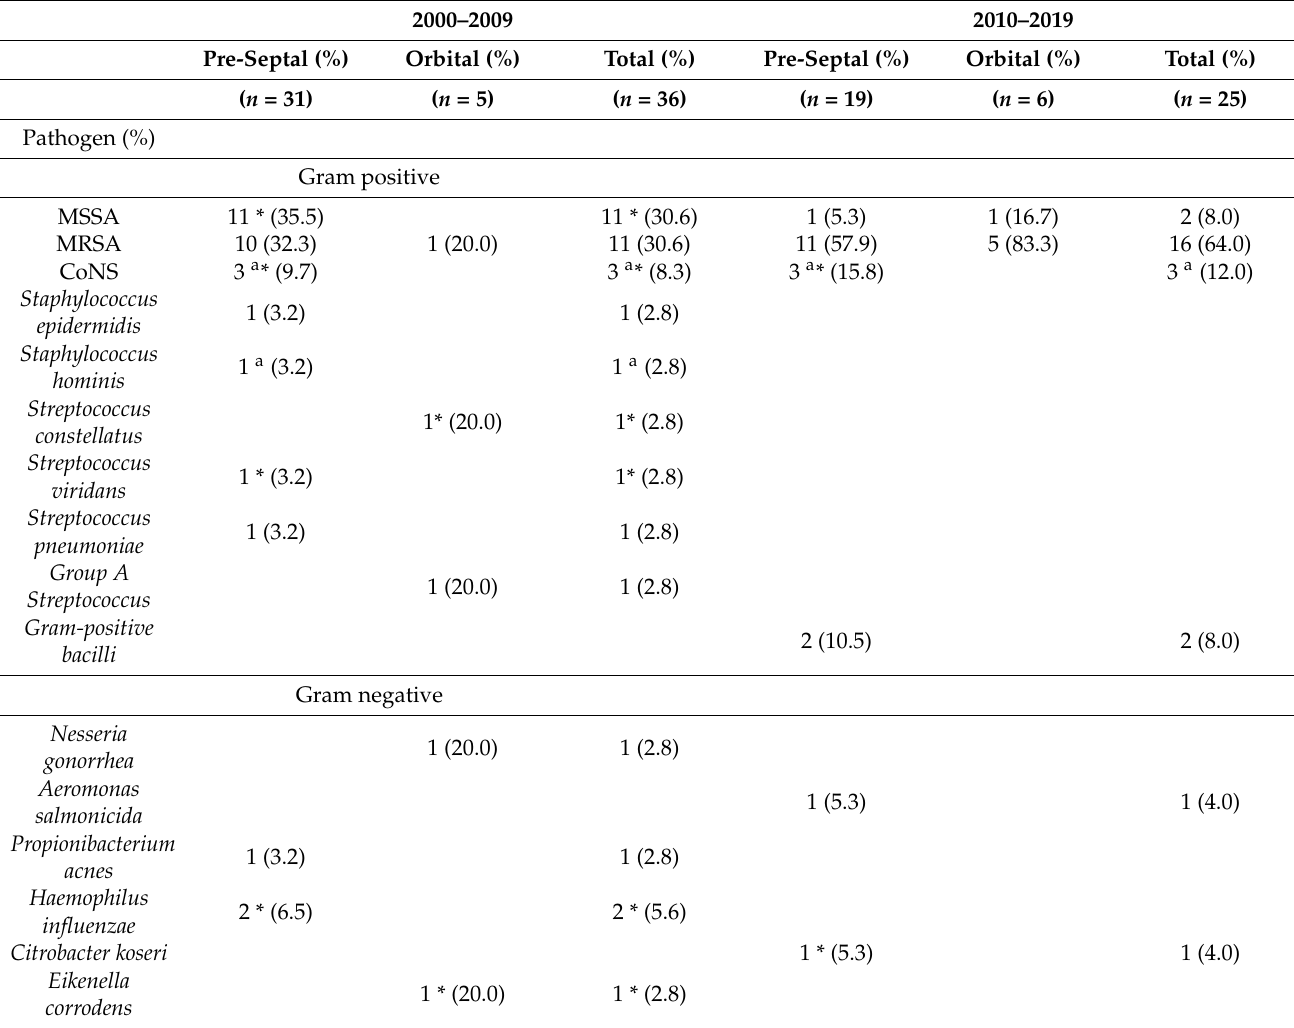
Table 4. All the pathogens isolated in periorbital cellulitis.